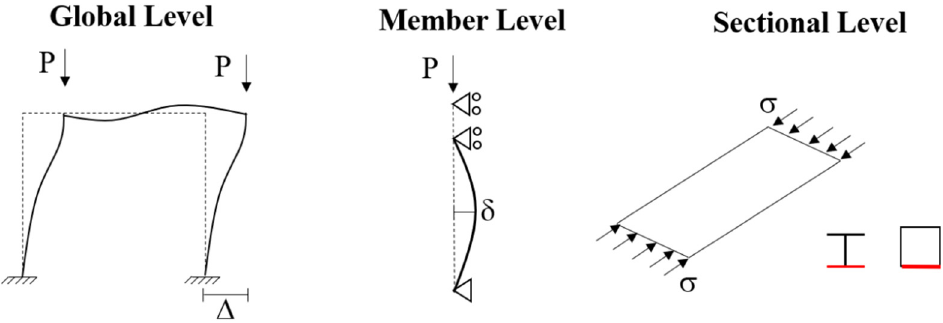
Figure 1. Instability phenomena on the metal structures.